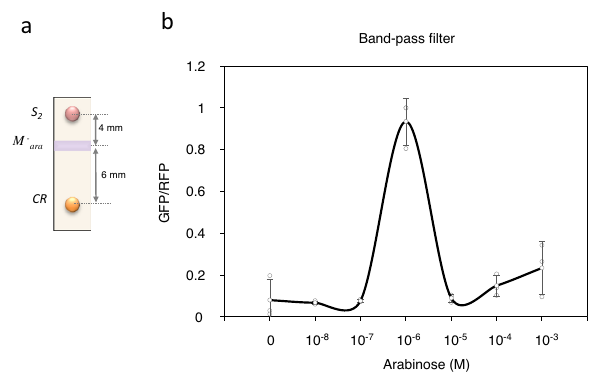
Fig. 6 Band-pass fi lter circuit. a Band-pass fi lter implementation is outlined by a schematic representation of the cells used for the paper strips and their corresponding distance points. M − ara are negative modulatory cells responding to arabinose. S 2 cells produce AHL upon arabinose induction and CR are the reporter cells. b Circuit response upon increasing concentrations of the external input, i.e. arabinose. Error bars are the standard deviation (SD) of three independent experiments. Data are presented as mean values ± SD. Source data are provided as a Source Data fi